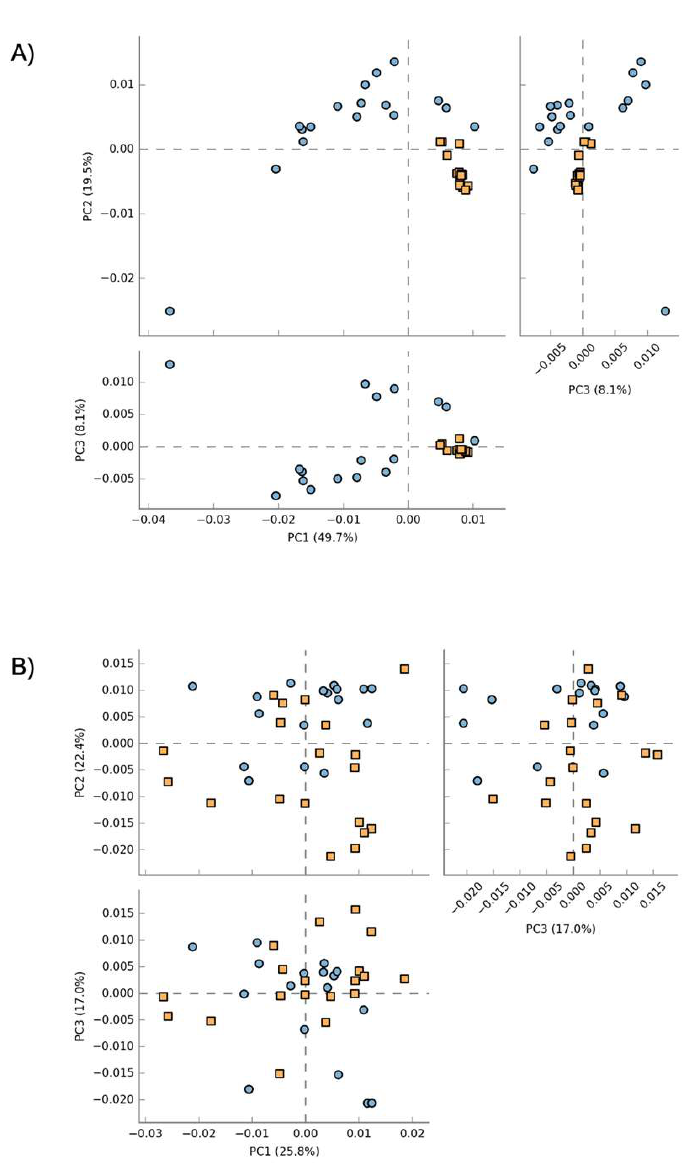
Figure 6. Principal coordinate analysis (PCA) plot of the functional pathways predicted by Picrust2 of the blood microbiome ( A ) and the fecal microbiome ( B ). Blue dots represent healthy dogs, while orange squares represent sick